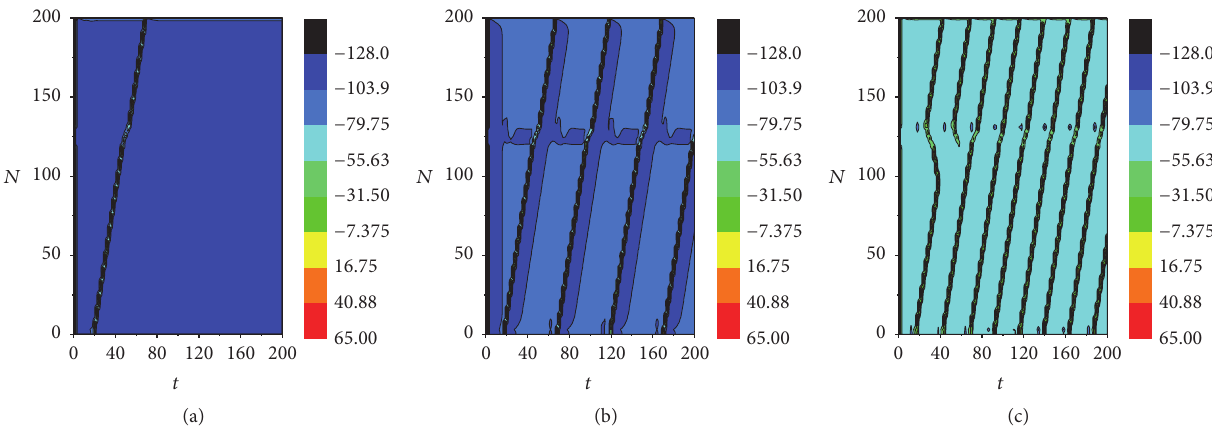
Figure 6: Wave propagation along axon when autapse is developed from node 𝑖 = 3,135 , for gains (a) 𝑔 𝑐 = −0.5 , (b) 𝑔 𝑐 = −1 , and (c) 𝑔 = −2 : the time delay in electric autapse is set as 𝜏 = 10 and external forcing 𝐼 𝑐 by decreasing the conductance of sodium from 𝐺 Na = 120 mS/cm 2 to 𝐺 Na = 25.5 mS/cm 2 : inhibitor chemical autapse is used by setting 𝑉 = −2 , the axon is divided into 201 nodes, and the injured area is marked from nodes 𝑖 = 120 to 130 . The snapshots are illustrated in color syn